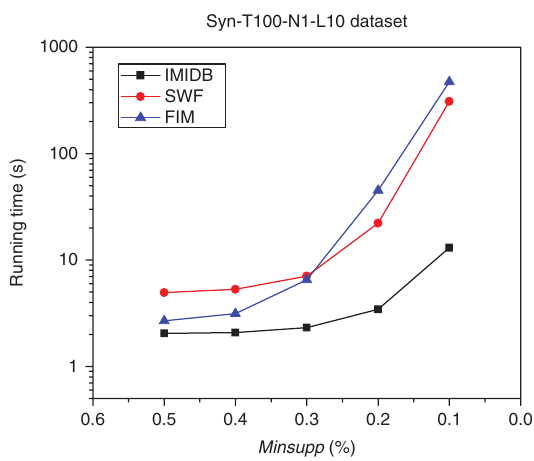
Figure 10: Running Time Comparison – Syn-T100,N1,L10 Dataset.